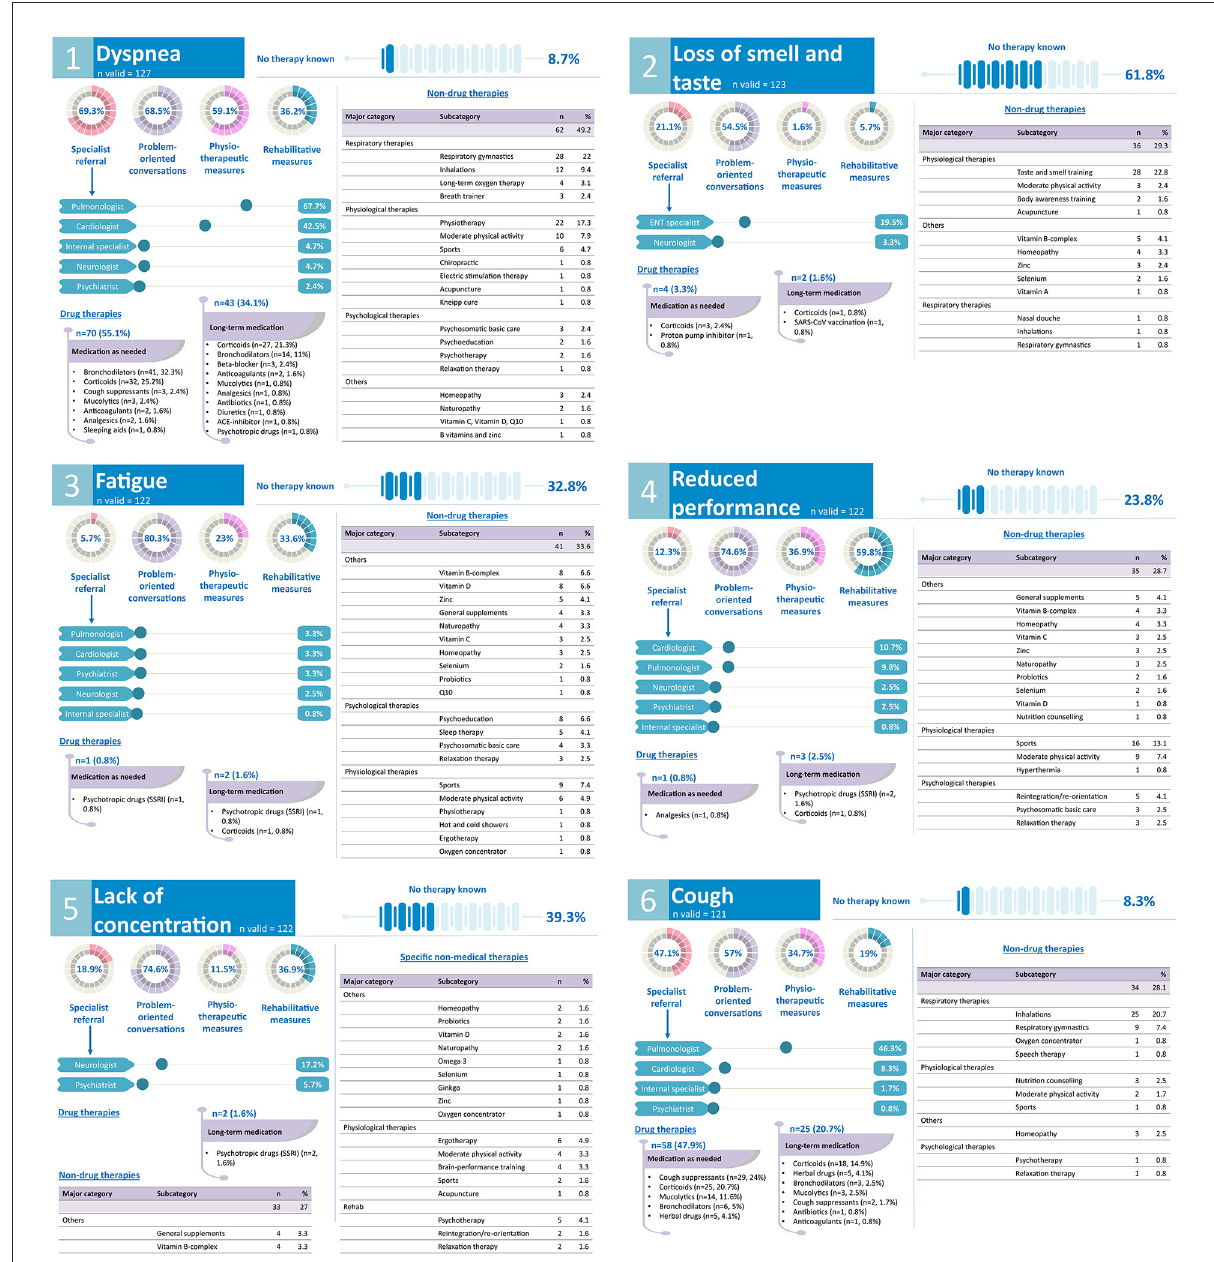
FIGURE4 GPs’ treatment and rehabilitation plans of common long COVID symptoms: dyspnea, loss of smell and taste, fatigue, reduced performance, lack of concentration, cough. Kneipp cure, hydrotherapy; Q10, coenzyme Q10.